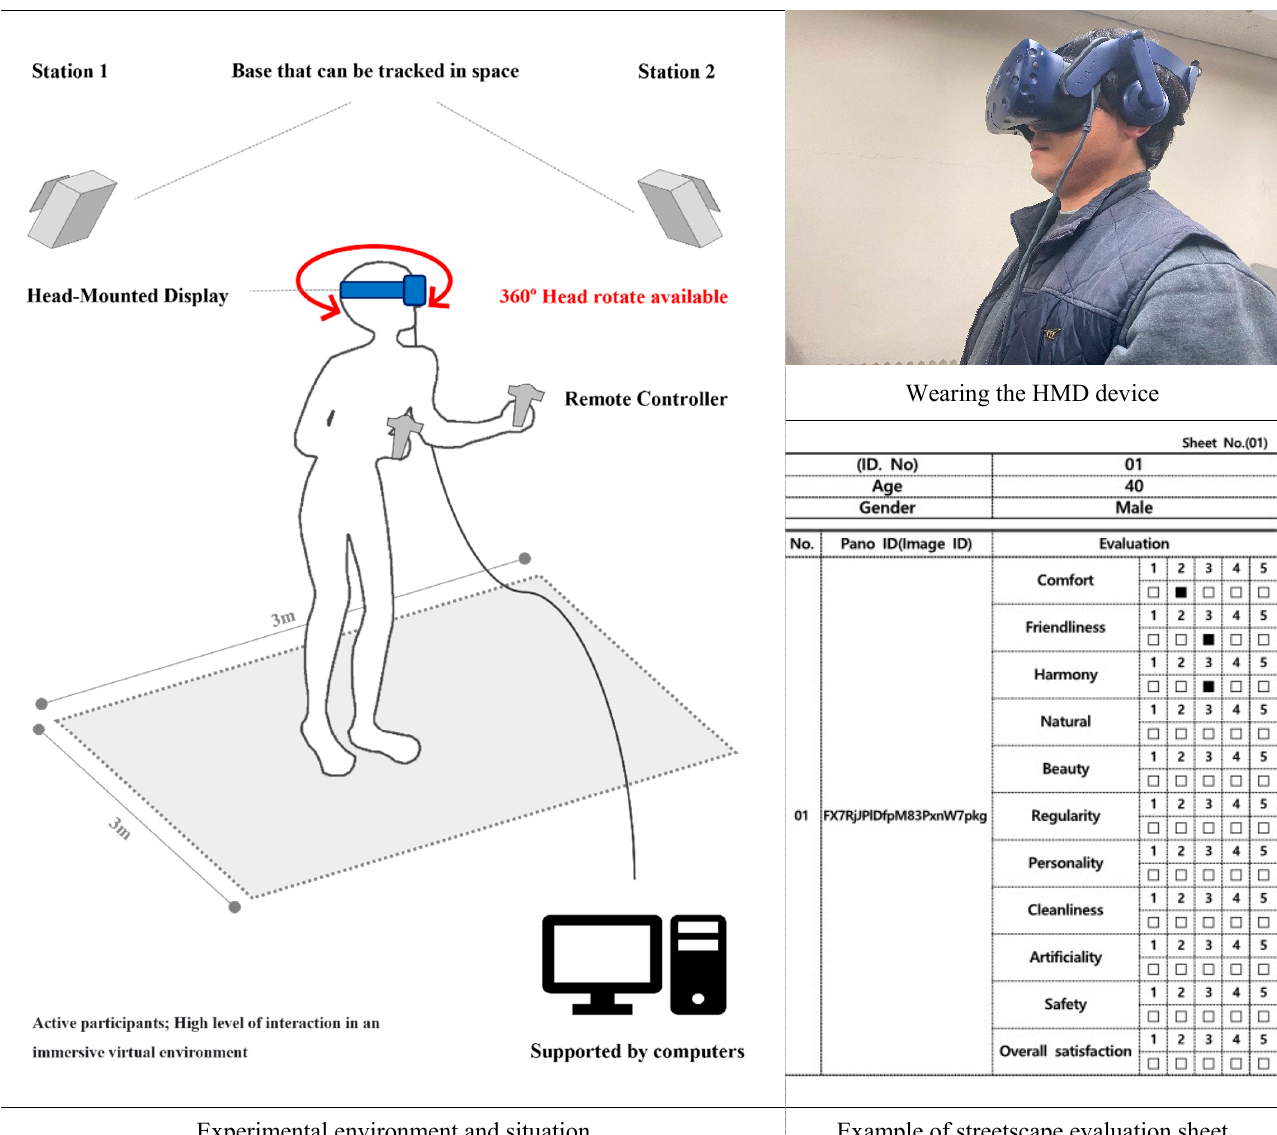
Figure 4. Example of the VR-based urban streetscape assessment.